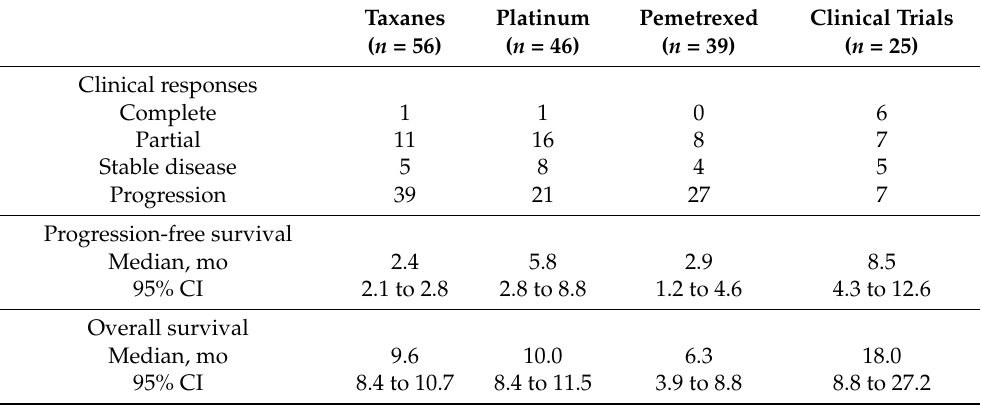
Table 2. Outcomes of third-line therapy according to